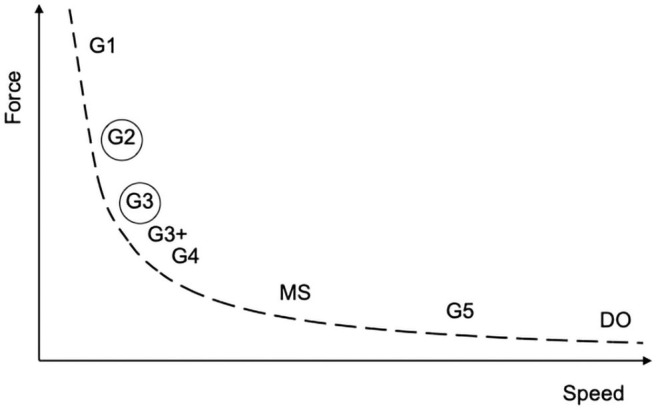
Schematic illustration of the relationship between force and speed for the eight sub-techniques of ski skating. G1 (Gear 1), G2 (Gear 2), etc. refer to the nomenclature for Swedish ski skating techniques. G3+, double-push skating; MS, marathon skating and DO, downhill. The sub-techniques circled were the focus of the present investigation.